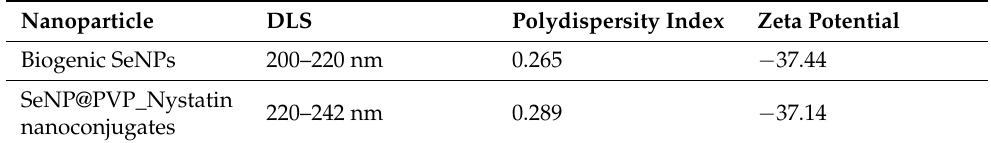
Table 1. DLS, Zeta Potential